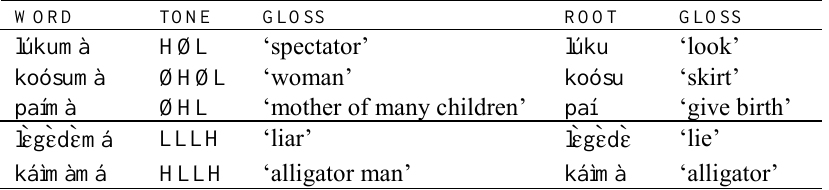
Table III: Words with the agentive suffix in